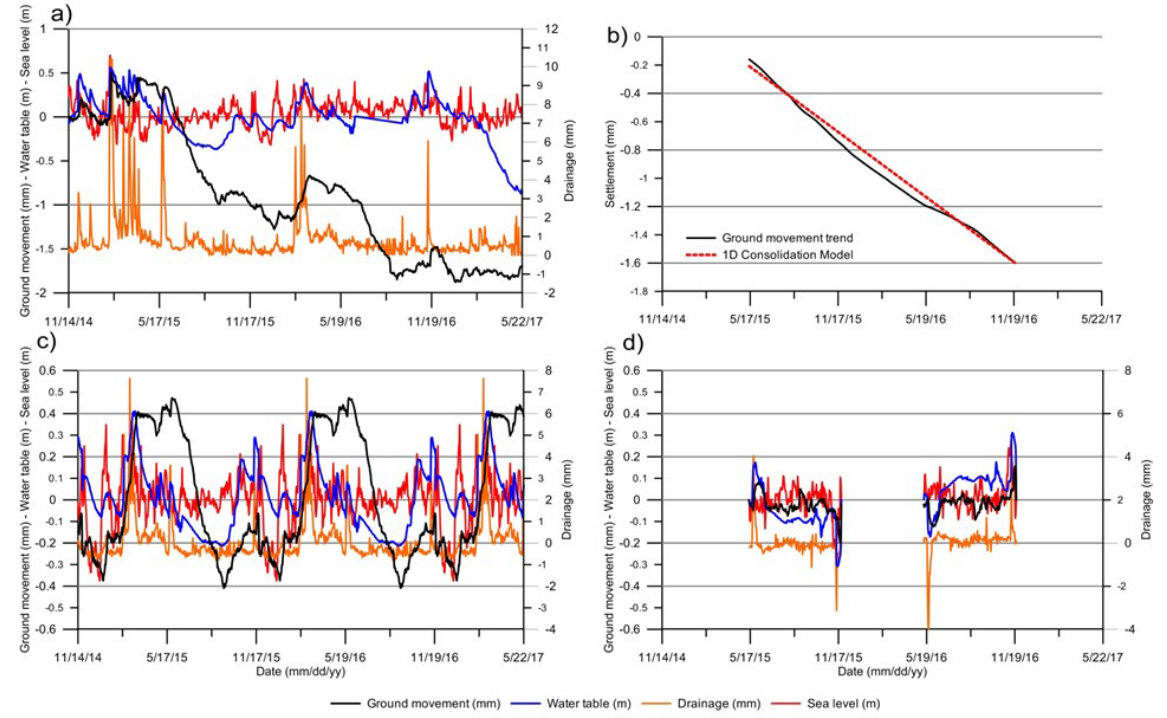
Figure 3. (a) Time series of recorded data. (b) Trend component of the settlement time series data (solid black line) compared with the 1-D best fit ( R 2 = 0 . 99) consolidation model (dashed red line line). (c) Seasonal and noise (d) components of the settlement, land reclamation drainage in mm equivalent of water per unit area, sea level and water table time series data (from Antonellini et al.,